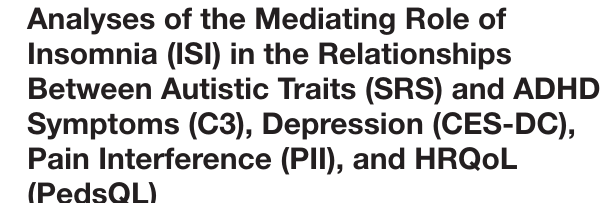
of insomnia (ISI) (M) in the relationships between ADHD symptoms (C3) (X) and the three dependent variables (Y): depression (CES-DC), pain interference (PII), and